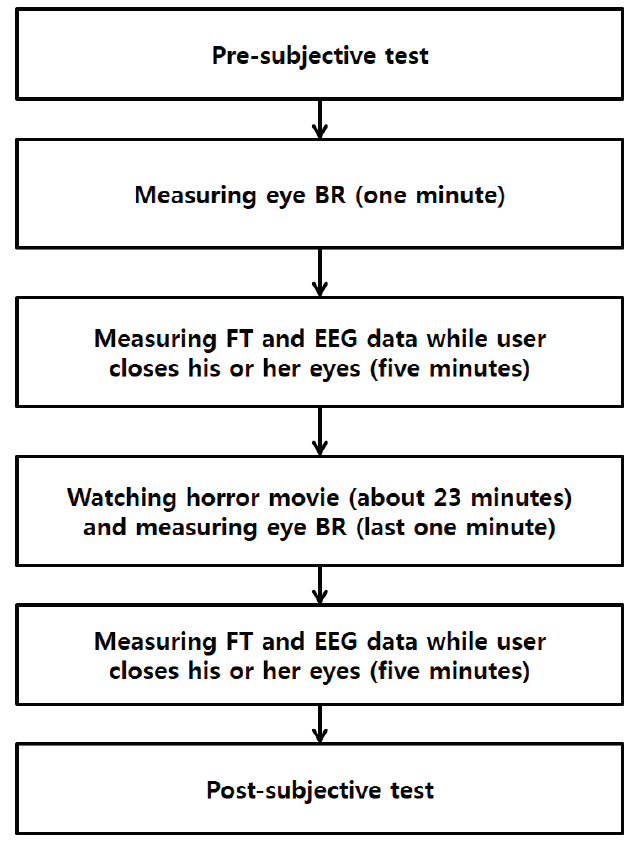
Figure 1. Flowchart of the experimental procedure of our research (BR is blinking rate and FT is facial